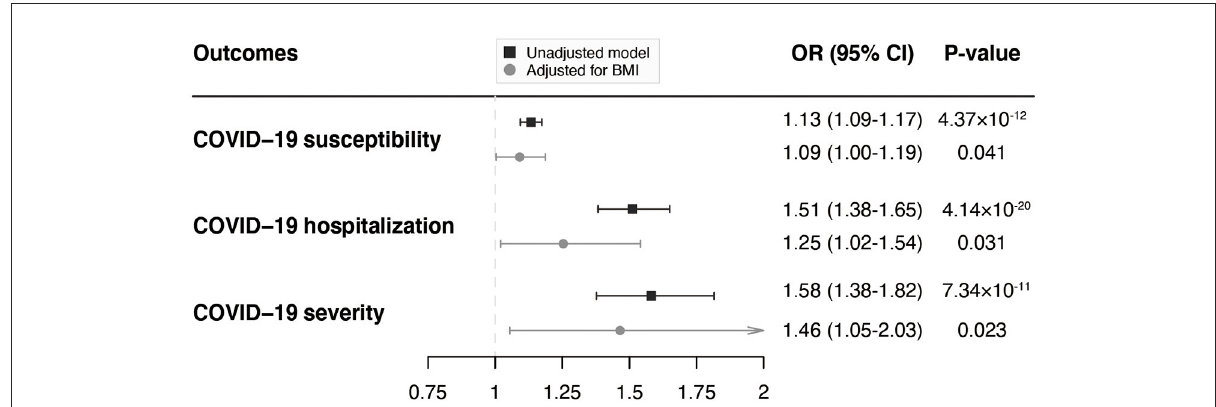
FIGURE3 MVMR analyses of the associations of genetically predicted VAT mass with COVID-19 outcomes adjusting for BMI. MVMR, multivariable Mendelian randomization; VAT, visceral adipose tissue; COVID-19, Coronavirus Disease 2019; BMI, body mass index; OR, odds ratio; CI, confidence